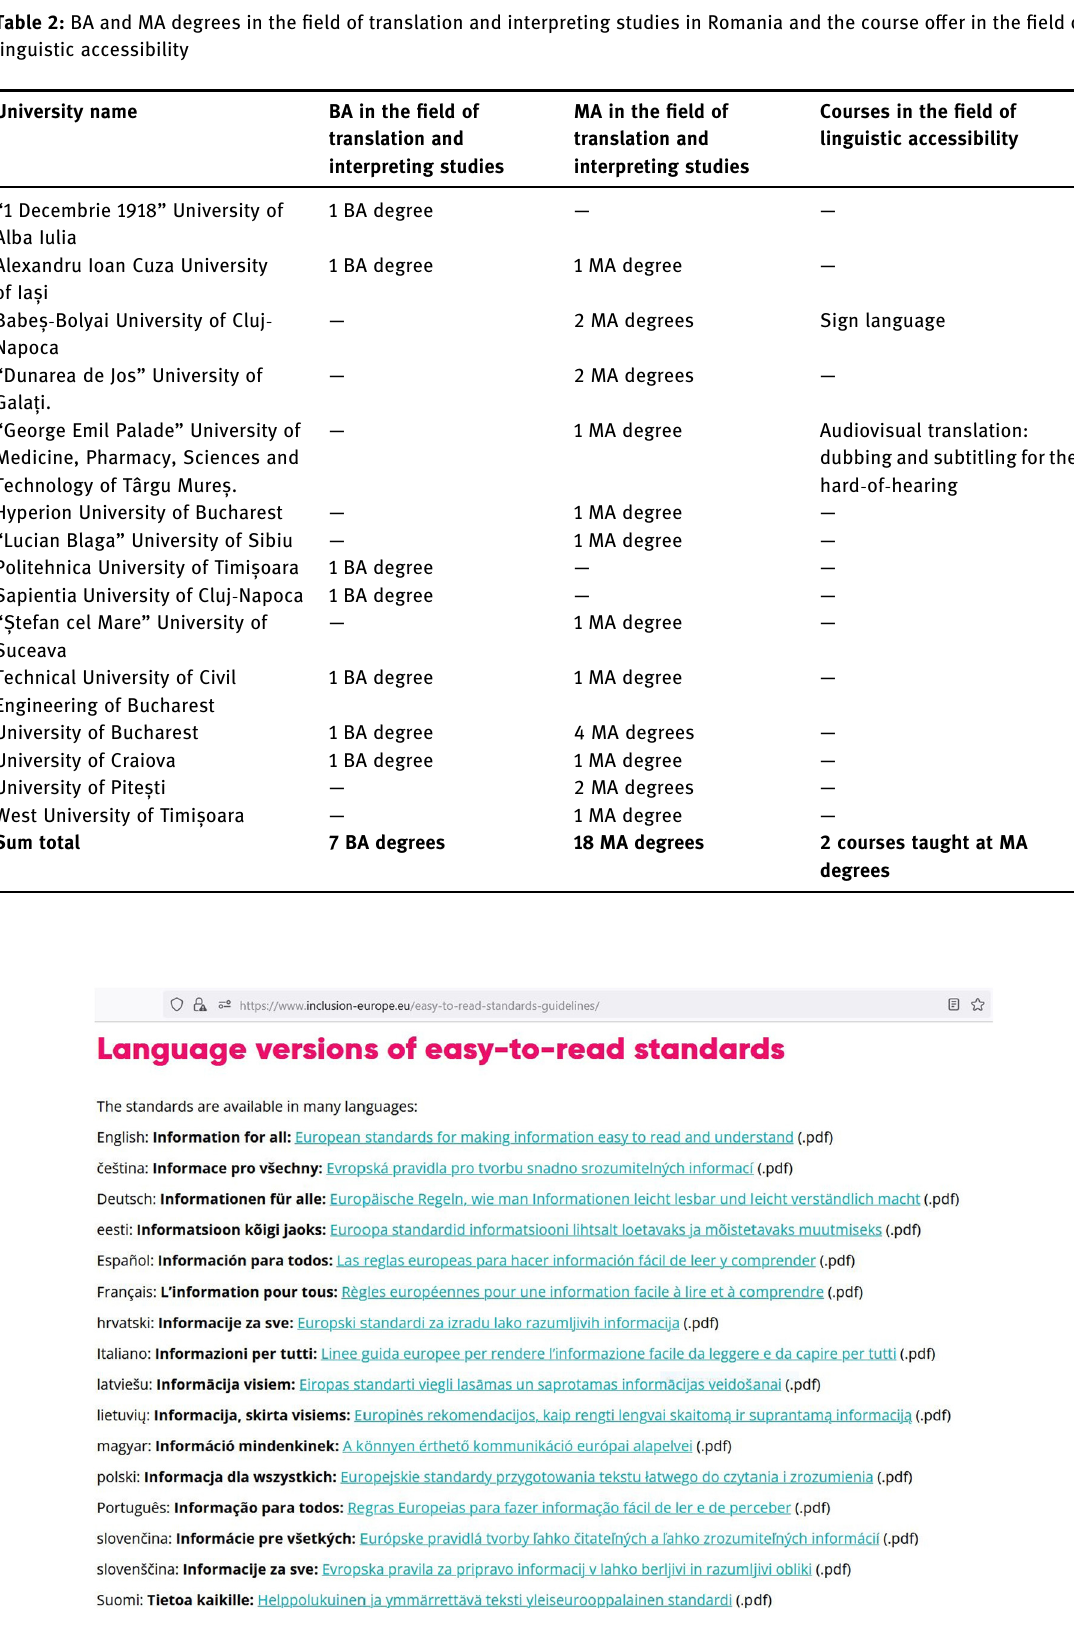
Figure 6: European guidelines for making information easy to read and understand , available in several